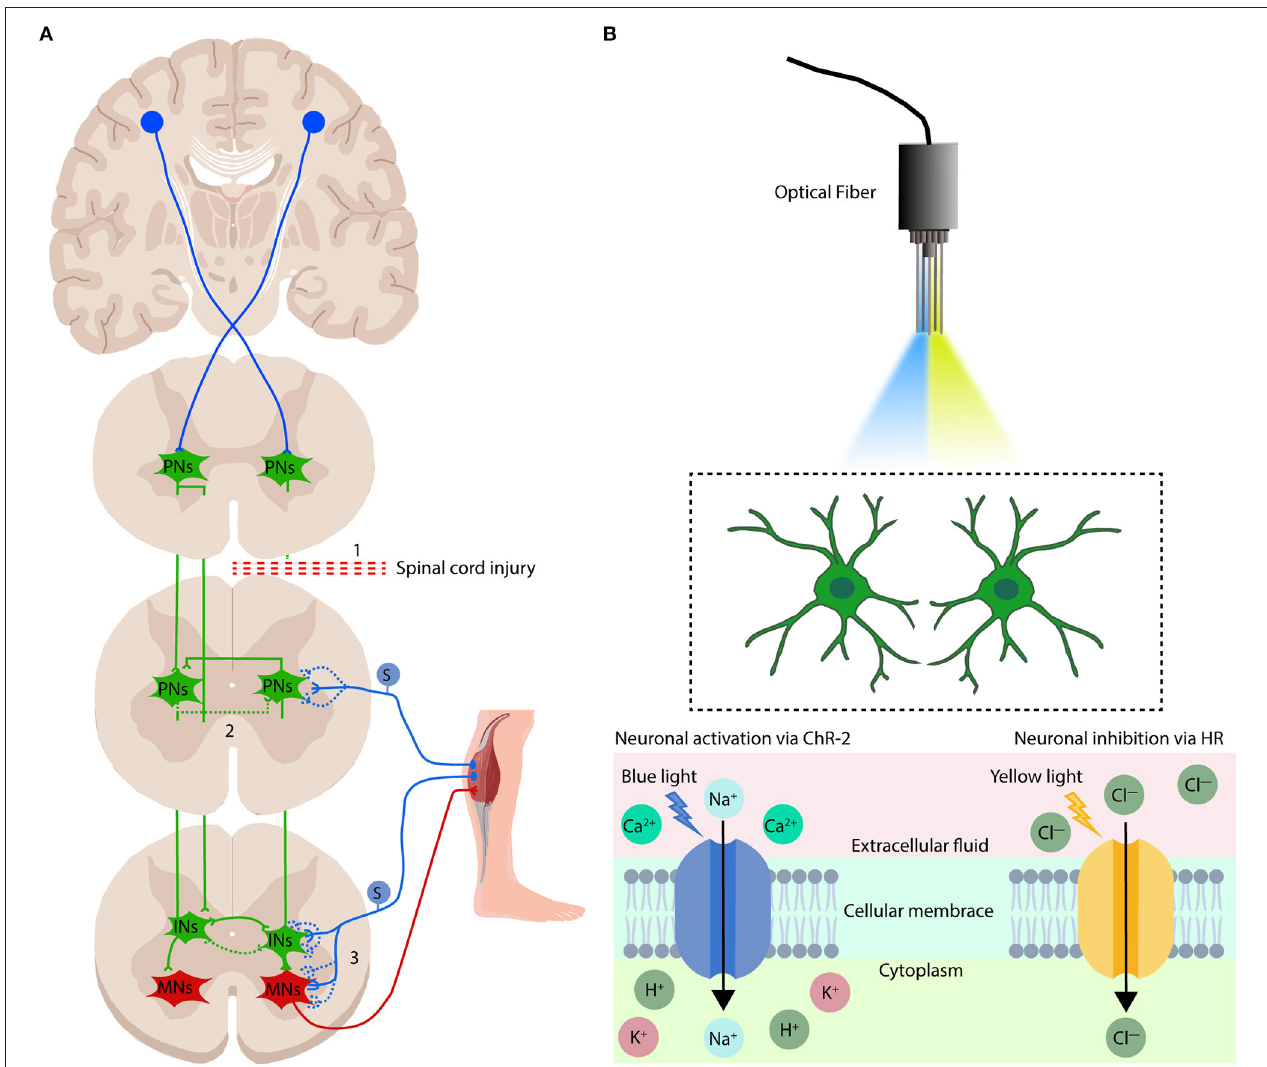
FIGURE 2 | Mechanisms of electrical modulation and optogenetics modulation in the treatment of spinal cord injury. (A) There are three potential mechanisms by which electrical stimulation regulation promotes sensorimotor function repair after spinal cord injury: (1) cortical stimulation promotes regeneration of the free ends of the CST; (2) spinal cord stimulation can promote the formation and activation of circuits established by spared PNs that lead to the re-emergence of locomotion and sensation when SCI results in disruption of the flow of motor instructions from the brain and brainstem to the spinal motor circuits; and (3) electrical modulation can recruit proprioceptive afferents, which have been proposed to be the most influential in regaining volitional control of affected muscles, and rebuild the sensorimotor circuits which were disruption when spinal cord injury. PNs, propriospinal neurons; INs, interneurons; MNs, motoneurons. S, sensory neurons. The blue and green dotted lines show the rebuild of neuronal connections after electrical modulation. (B) Overview of the optogenetics system. The implanted optical fiber is guided to the target tissue, and the target neuron is activated or inhibited by illumination with blue or yellow light. Specific neurons in the cerebral cortex or spinal cord are simplified into two green neuron patterns in the figure. Blue light (470-nm wavelength) changes the conformation of the transmembrane ion channel protein ChR2, allowing positively charged ions to flow into the cytoplasm, leading to depolarization of neurons. Yellow light (580-nm wavelength) alters the conformation of the transmembrane ion pump protein HR, which allows negatively charged ions to enter the cytoplasm, leading to hyperpolarization of